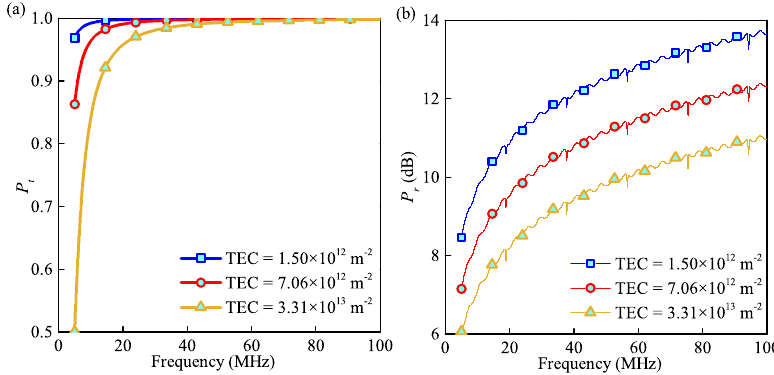
Figure 4. ( a ) P t and ( b ) P r versus wave frequency under three